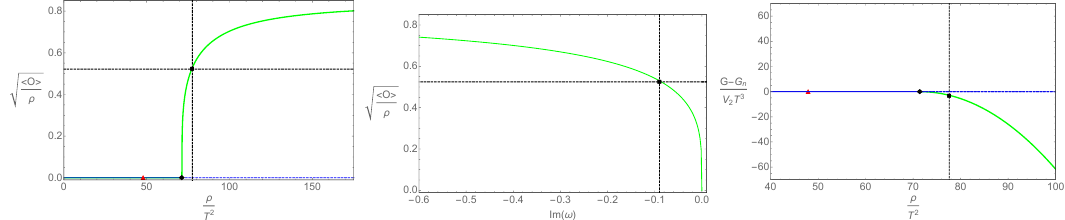
Figure 1 . A typical 2nd order phase transition. Left : the normalized scalar condensate as a function of the dimensionless charge density. Middle : the imaginary part of the amplitude mode of the superfluid phase. Right : the Gibbs free energy difference between the normal phase and the superfluid phase. All figures are for λ = τ = 0 and m 2 = − 2 , q = 1 . The black rhombus indicates the position of the critical point. The square and the triangle as well as the dashed black lines are used to mark the same position in different